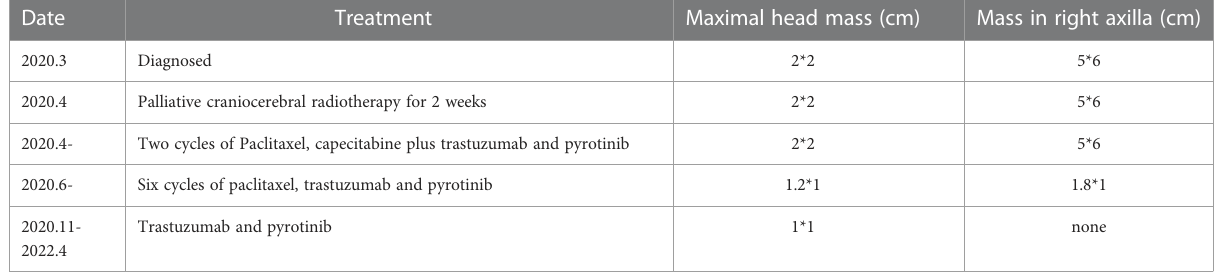
TABLE 1 The brief course of